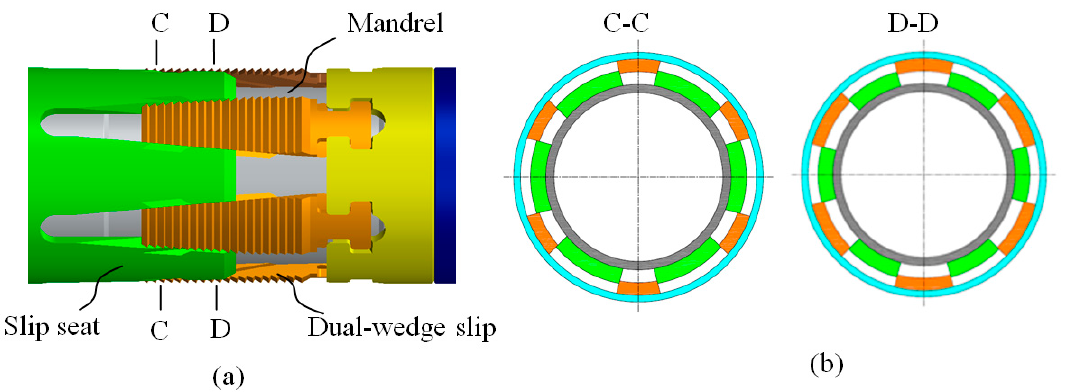
Figure 4. Concept of hanging mechanism with dual-wedge slips. ( a ) 3-D CAD model; ( b ) cross sectional view.